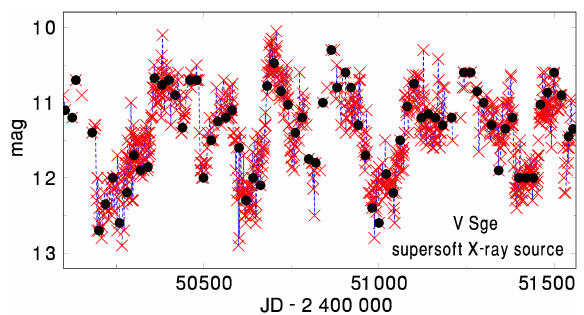
Figure 4: Comparison of the observed (one-day means of AFOEV data (crosses)) and the approximated sam- pled data (closed circles) of the supersoft X-ray source V Sge. Heavily sampled data are expected from the Gaia satellite.